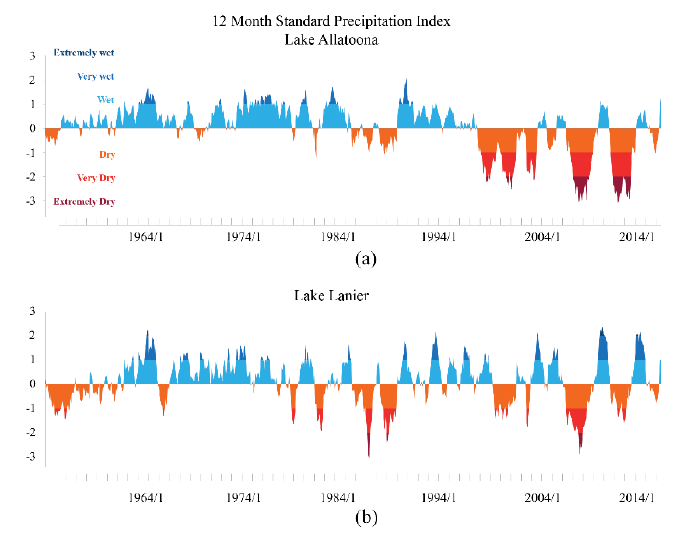
Figure 7. The Standard Precipitation Index (SPI) for the two reservoirs show several droughts within the last decade, notably from 2007 to 2009. (a) 12-month SPI at Lake Allatoona; (b) 12-month SPI at Lake Lanier.